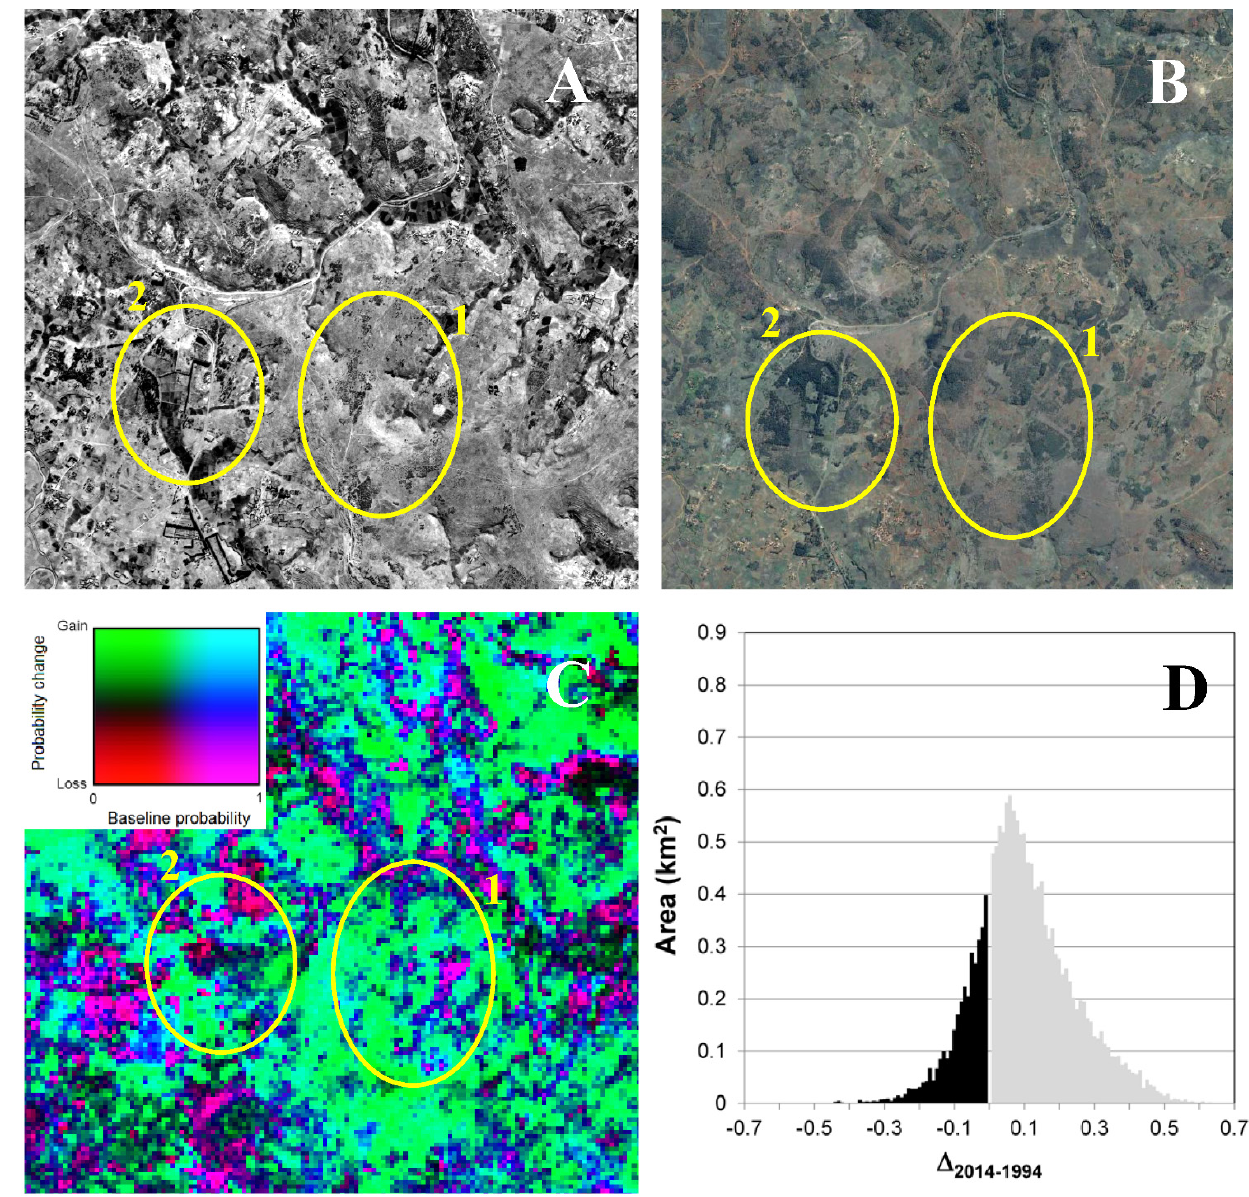
Figure 5. Dynamics of woody cover at Site 03, south of the town of Ambatolampy (19°25'S, 47°25'E). ( A ) Aerial photograph taken in 1991. ( B ) CNES Astrium image taken in 2013. ( C ) Change map based on Landsat imagery (see Figure 2). ( D ) Histogram depicting the frequency distribution of the delta of woody cover probability values between 2014 and 1994 based on Landsat imagery. Woody cover loss is represented in black, while gain is represented in gray. Ellipses in (A–C) relate to particular woody cover dynamics described in the text. See Figure 1 for the geographic location of Site 03 within the study